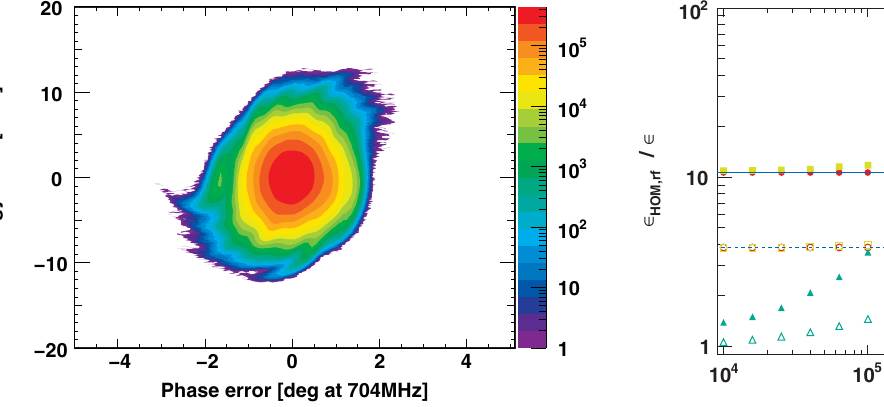
FIG. 17. 2D phase space histogram at the exit of 1000 linacs, where rf errors and one HOM is present. There is no significant change in the phase space histogram compared to Fig. 7. Settings: uniform distributed rf errors (0.5 (cid:8) in phase and 0.5% in magnitude), N ¼ 1000 , see Table